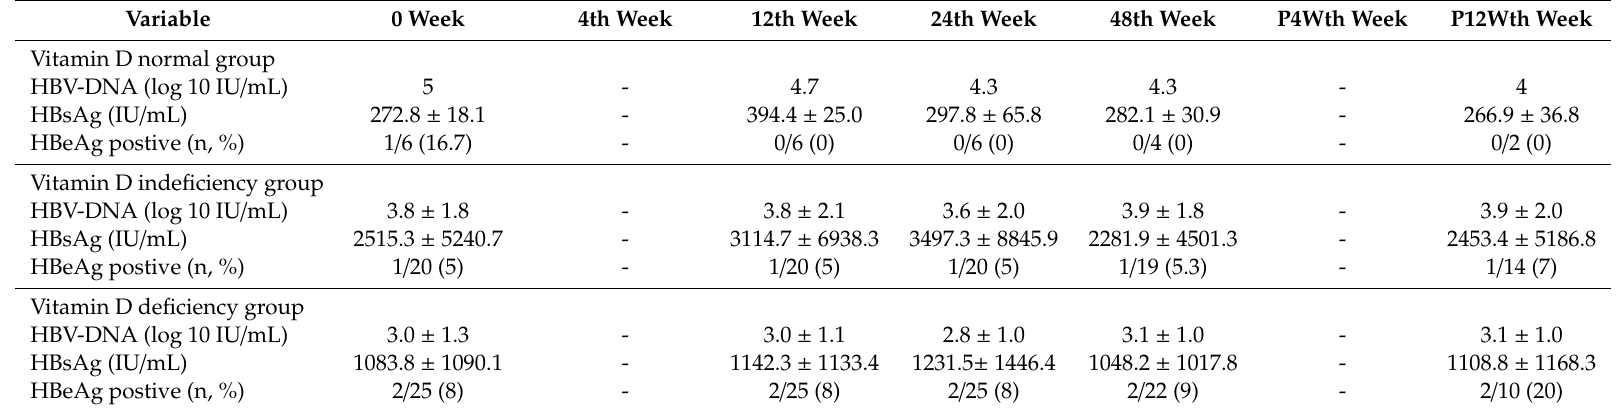
Table 3. E ff ect of serum 25(OH)Vitamin D concentration on hepatitis B virus data during oligo fucoidan supplementation.